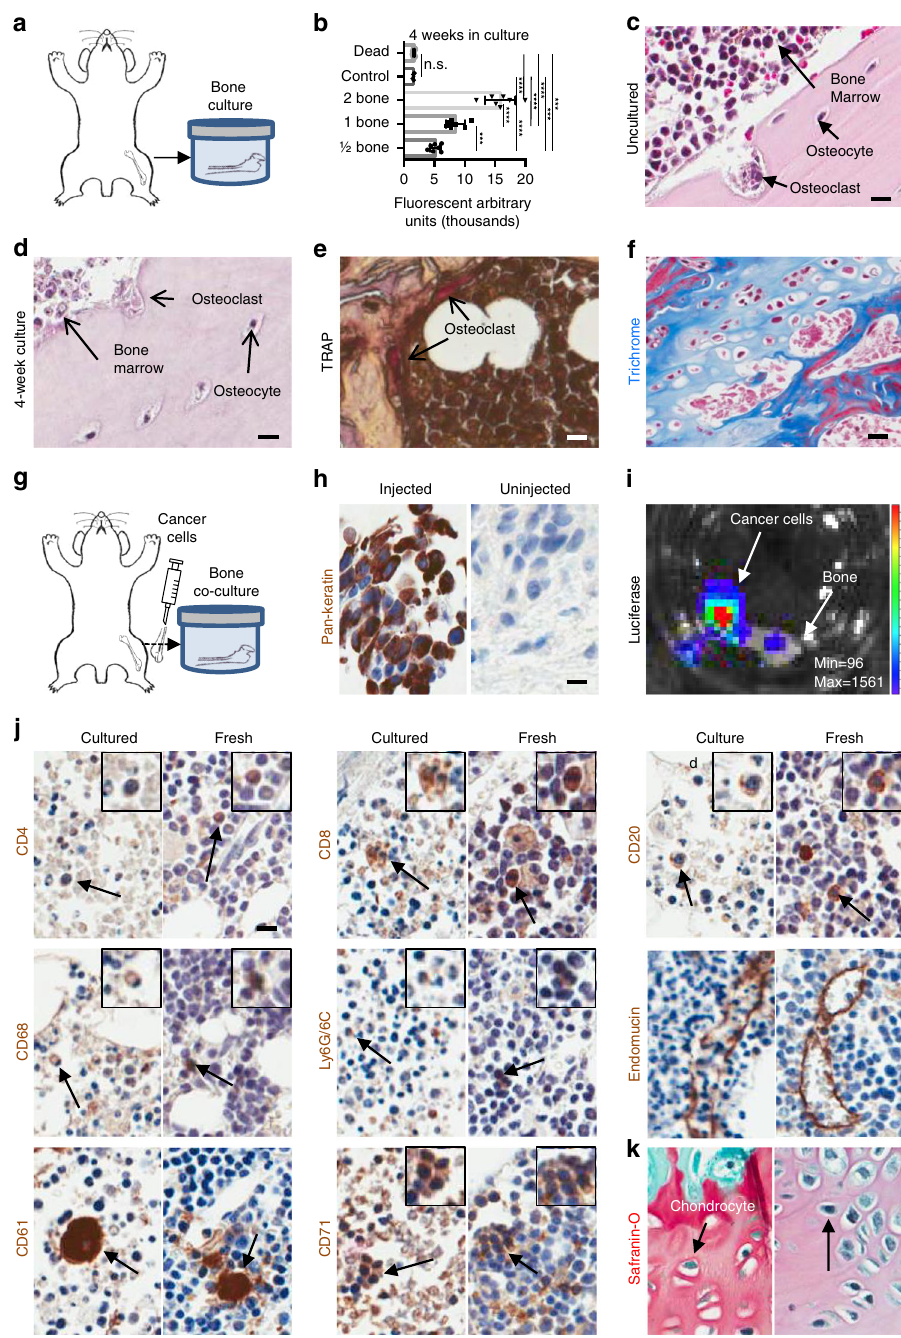
Fig. 1 Bone, marrow, and cancer cells survive in ex vivo co-cultures. a Experimental design of ex vivo bone cultures using mouse bone explants. b Metabolic activity of ex vivo bone cultures compared to the metabolic activity of a dead bone and media controls. CellTiter-Blue (cell viability) assay to test metabolic activity of an increasing number of mouse bone explants in ex vivo culture after 4 weeks in culture ( p values obtained by Student ’ s t test, multiple comparisons). Lines show the mean and standard deviation. c H&E of a fresh, uncultured mouse bone sample (scale bar: 10 μ m). d H&E of a cultured mouse bone cultured for 4 weeks (scale bar: 10 μ m). e TRAP staining of a 4-week cultured mouse bone sample. Arrows show the localization of osteoclasts (scale bar: 10 μ m). f Masson ’ s trichrome staining on a mouse bone sample after 4 weeks in culture showing retention of collagen depositions shown in blue (scale bar: 20 μ m). g Experimental design of ex vivo mouse bone co-cultures grown with breast mammary epithelial cancer cells injected into the bone prior to culture. h Immunohistochemistry (IHC) for Pan-cytokeratin on a mouse bone co-cultured for 4 weeks with PyMT cancer cells (left) and an uninjected mouse bone cultured for 4 weeks (right). i Luciferase assay on a mouse bone sample colonized by a luciferase-expressing PyMT cell line. The intensity bars (rainbow) and scale information (Min/Max) for BLI signal are provided. Bioluminescent PyMT cancer cells co-localize with the bone in culture. j IHC of mouse bone marrow cells after co-culture with mammary epithelial cancer cells (left) compared to a fresh mouse bone sample (right) stained for CD4 + helper T cells, CD8 + cytotoxic T cells, CD20 + B cells, CD68 + macrophages, Ly6G/6C + neutrophils, endomucin endothelial cells, CD61 + megakaryocytes, CD71 + erythroid precursors, and k Safranin-O staining of a mouse bone post 4 weeks in co-culture (scale bar: 10 μ m). ***Signi fi cant at p < 0.001; ****signi fi cant at p < 0.0001; n.s. not signi fi